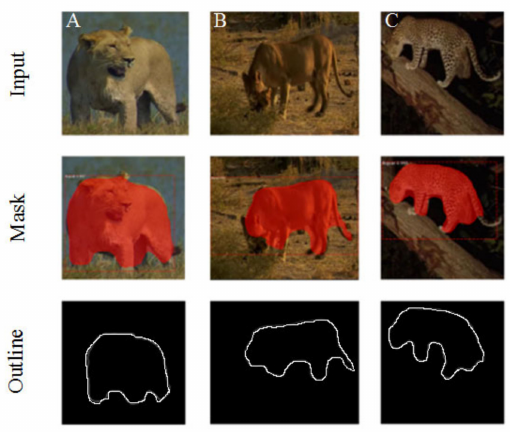
Figure 3. Example results of the Outline Mask region-based convolutional neural network (R-CNN) ( Top : original images of felines in different poses; middle : masks extracted by Mask R-CNN; and bottom : outline extracted by Outline Mask R-CNN).